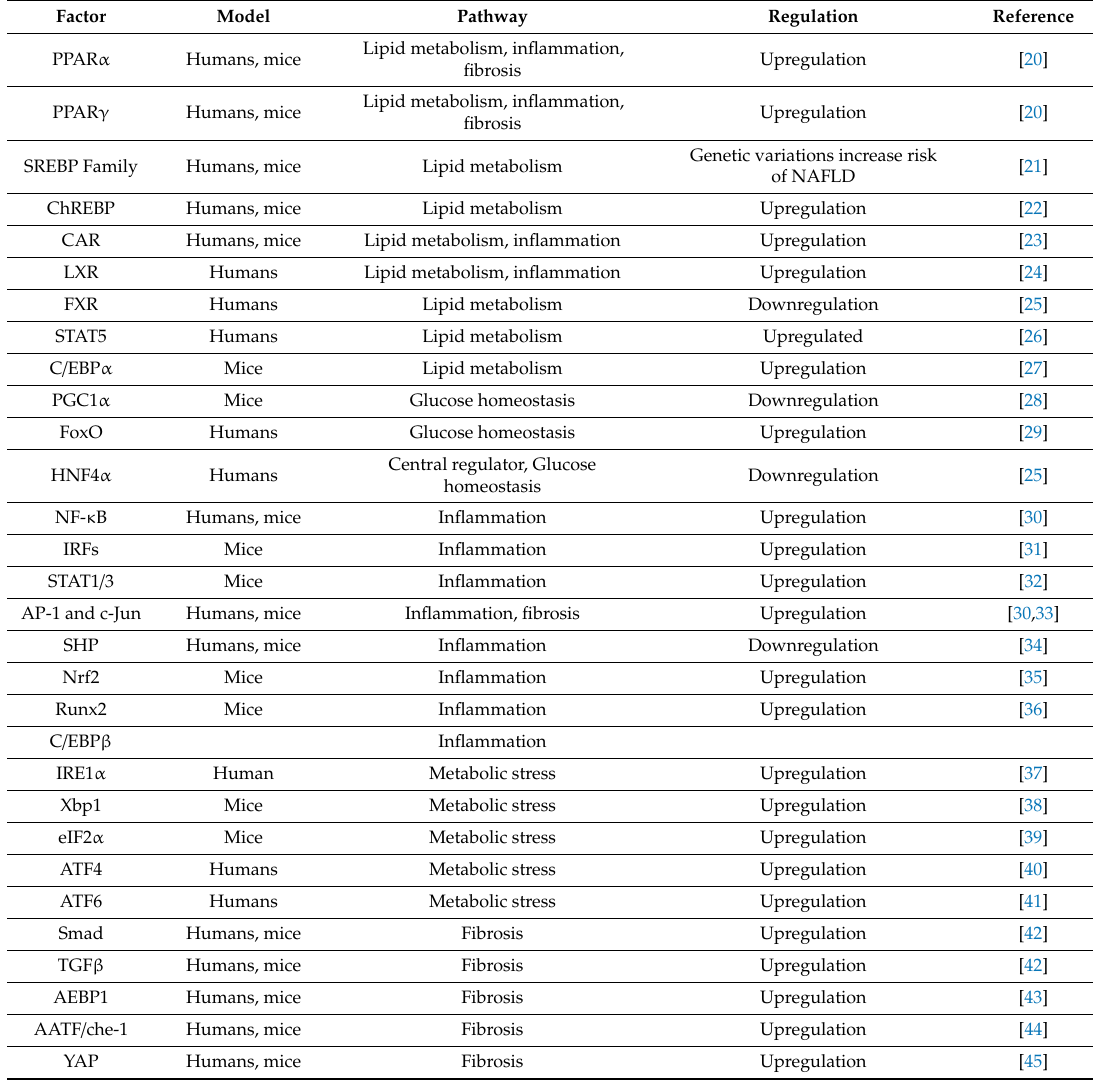
Table 1. Changes in the activity of transcription factors that regulate glucose and lipid metabolism, inflammation and fibrosis in the setting of NAFLD in humans and